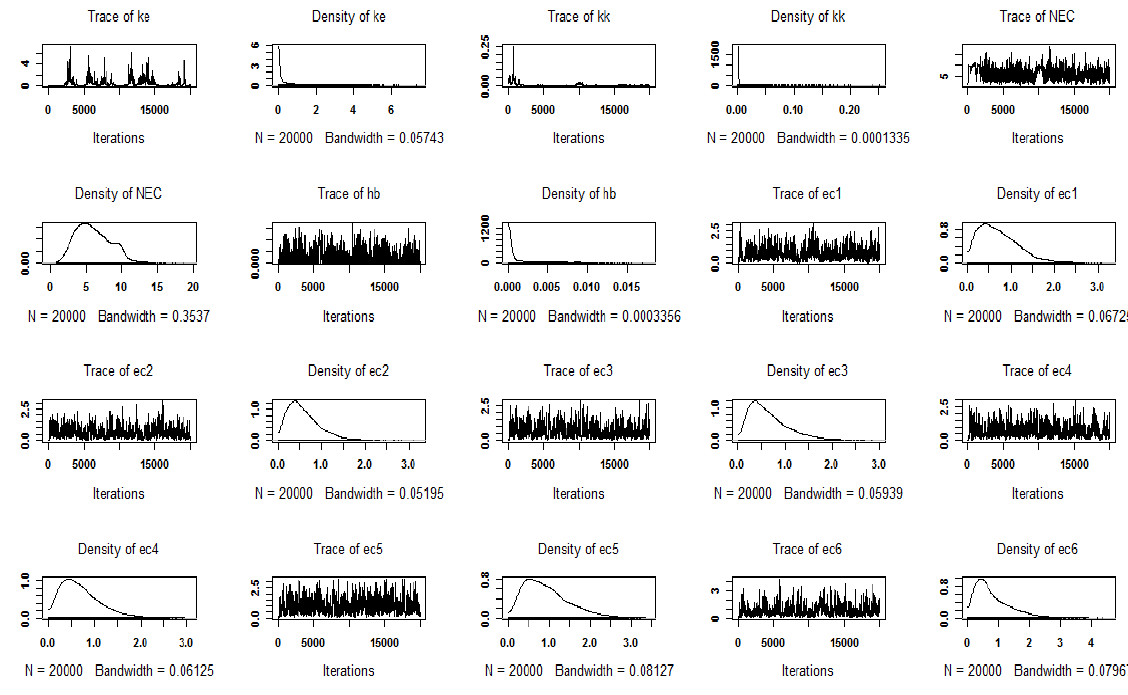
Fig. 1. MCMC chains plotting & summarizing